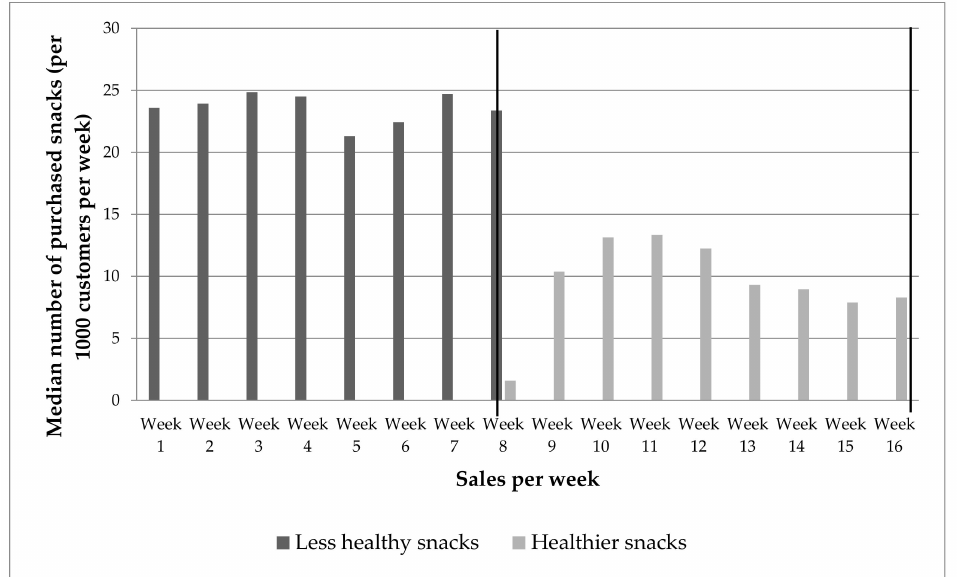
Figure 1. Median number of purchased snacks (per 1000 customers per week) of less healthy snacks and healthier snacks at checkout counters. The vertical lines mark the start and the end of the intervention period.